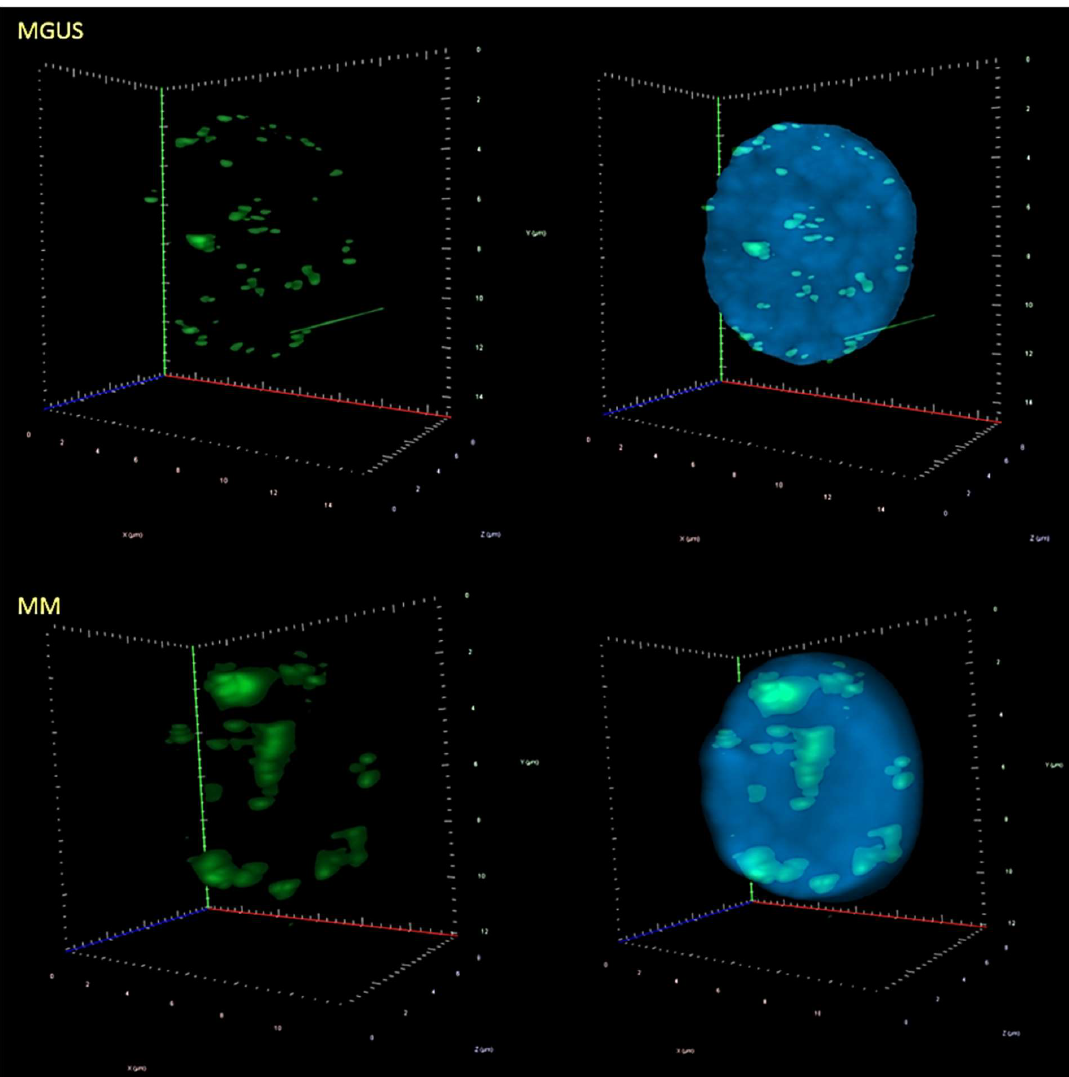
Figure 4. Three-dimensional (3D) images of representative nuclei from MGUS and MM patient samples showing the centromere distribution patterns. The FITC-labeled pan-centromeric probe in green indicates the centromeres in the cells, while the nuclei are counterstained in blue with DAPI. In MGUS samples, the centromeres generally occur as small punctate signals, but in MM samples they often form indistinct clusters.